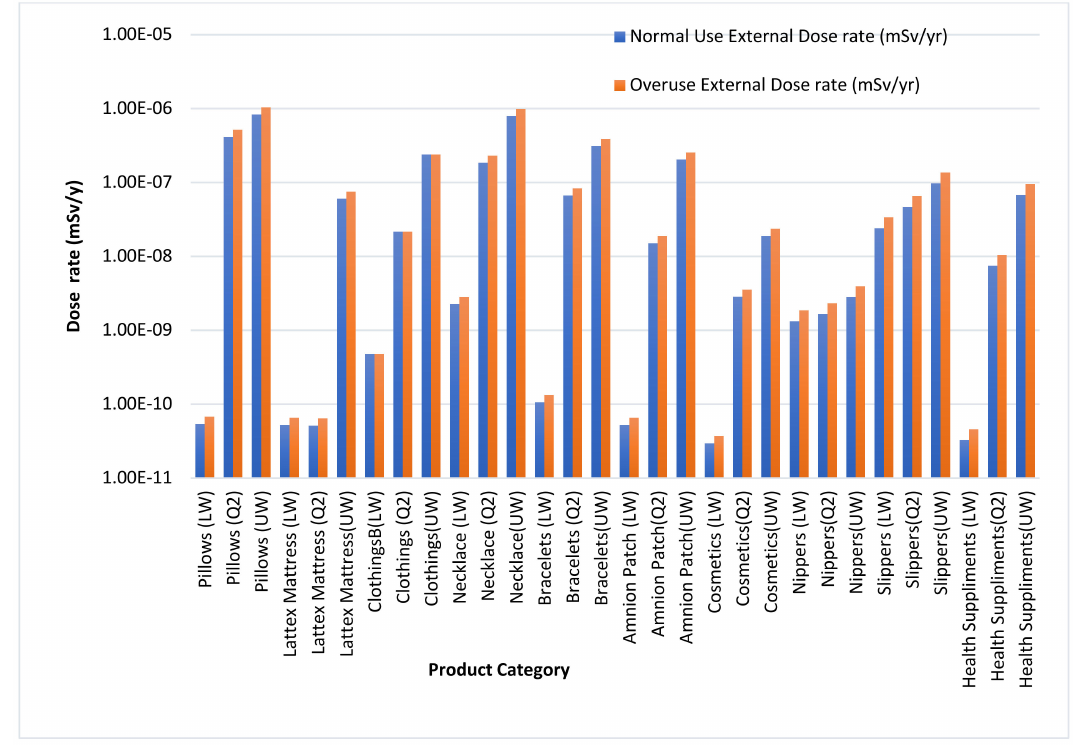
Figure 4. External dose using Microshield code.